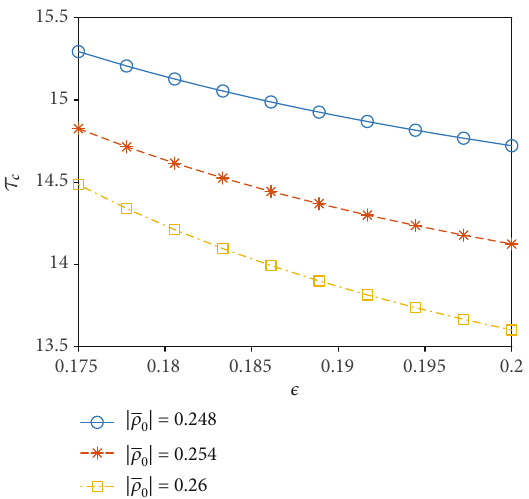
(cid:1) = 0 : 03 P 0 , through L . def c